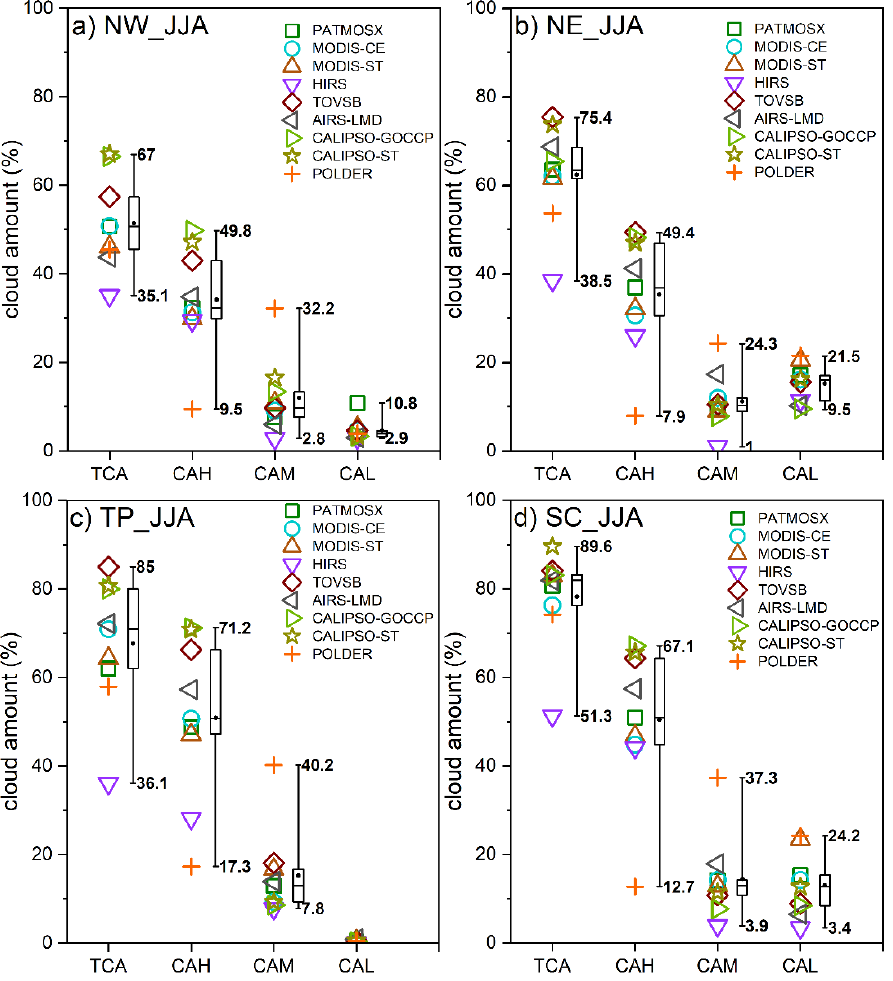
Figure 4. Averaged summer total cloud amount (TCA), high-level cloud amount (CAH), mid-level cloud amount (CAM), and low-level cloud amount (CAL) at 13:30 local time across different satellite datasets over four subregions of China: ( a ) NW region; ( b ) NE region; ( c ) TP region; and ( d ) SC region (unit: %), with symbols marked for different datasets. The box–whisker plot shows the maximum, minimum, upper quartile, lower quartile, and median for all datasets, and the black dots represent the algorithm mean. The specific values of the maximum and minimum values are also marked on the box – whisker plot.